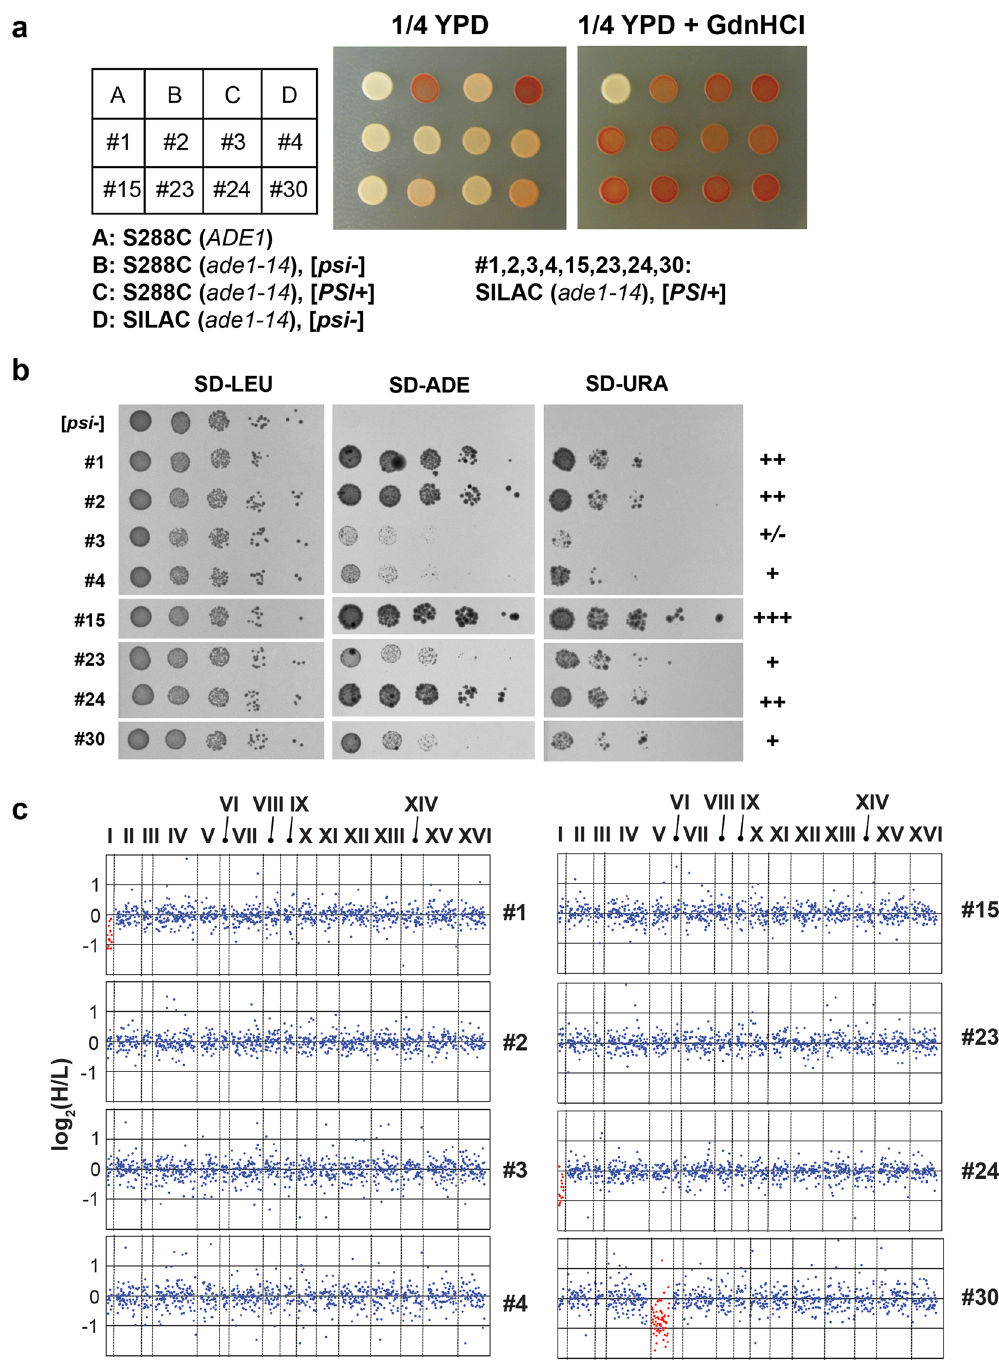
Figure 3. Characterizations of 8 selected [ PSI + ] SILAC strains. ( a ) The indicated strains were grown on the 1/4 YPD plates with and without GdnHCl. ( b ) The indicated [ PSI + ] SILAC strains were grown on the indicated synthetic defined (SD) plates containing 2% dextrose. ( c ) Scatter plots of log 2 (H/L) of the indicated [ PSI + ] SILAC strains in which proteins were ranked based on their corresponding gene chromosomal